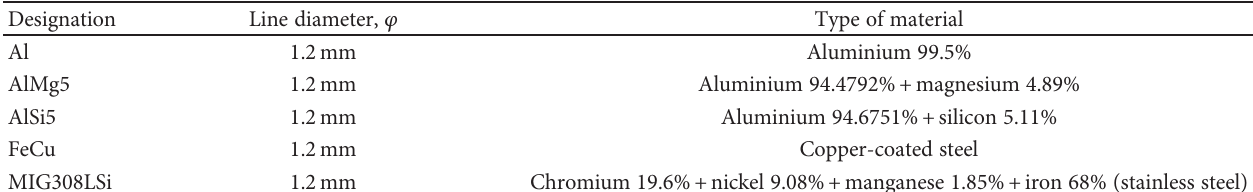
Table 1: Designations and parameters of the materials used for production of tested models of power lines with a delta cable